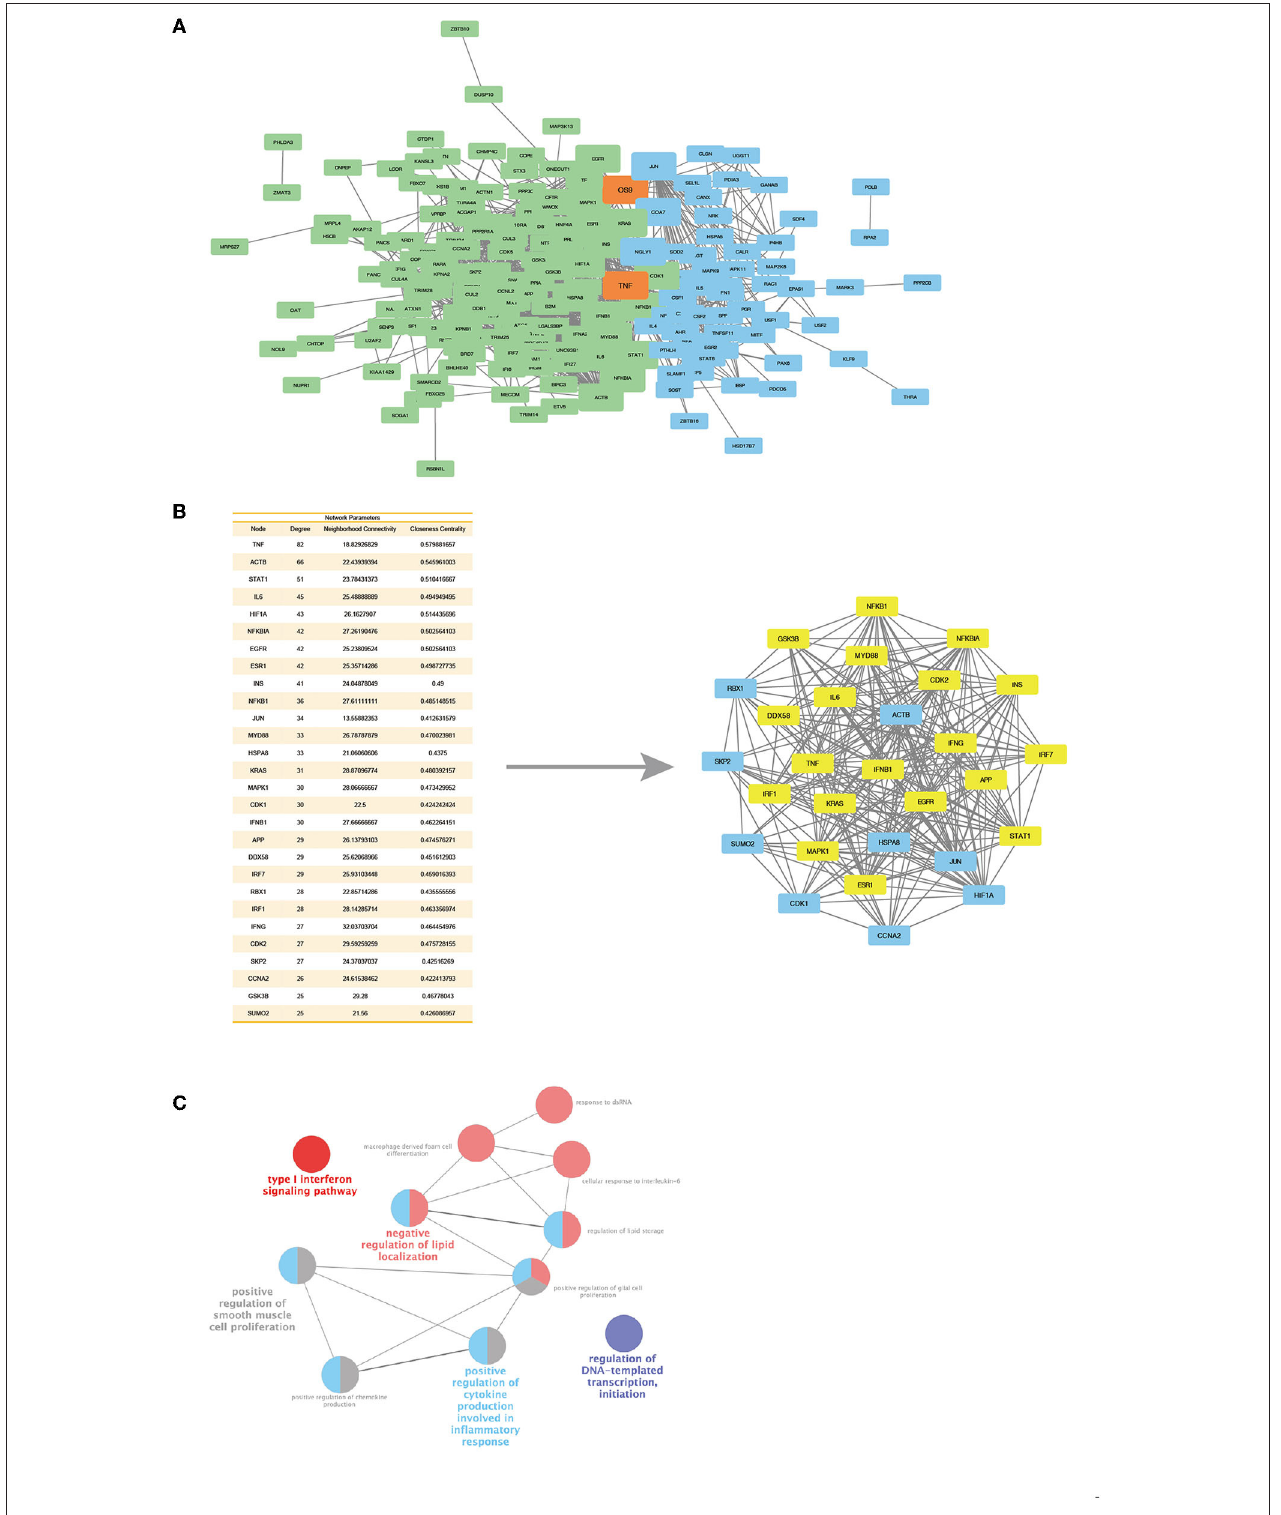
FIGURE 4 | Protein interaction networks of ACP5 and SAMHD1 have connections and a core cluster with significant connections with two networks. (A) Merge of ACP5 protein network (green) and SAMHD1 protein network (blue) with overlap nodes in both networks (orange). The size of nodes represents the degree and betweenness of nodes. (B) Left: The table outlines the degree, neighborhood connectivity, and closeness centrality values of the core cluster nodes. Right: Networks of core cluster in merge of ACP5 protein network and SAMHD1 protein network. The yellow nodes are the densely connected MCOD clusters, based on their parameters, including connectivity, degree, and centrality. (C) ClueGo analysis identifies KEGG pathways and biological processes linked to the essential proteins in the MCOD clusters. Frontiers in Pediatrics |